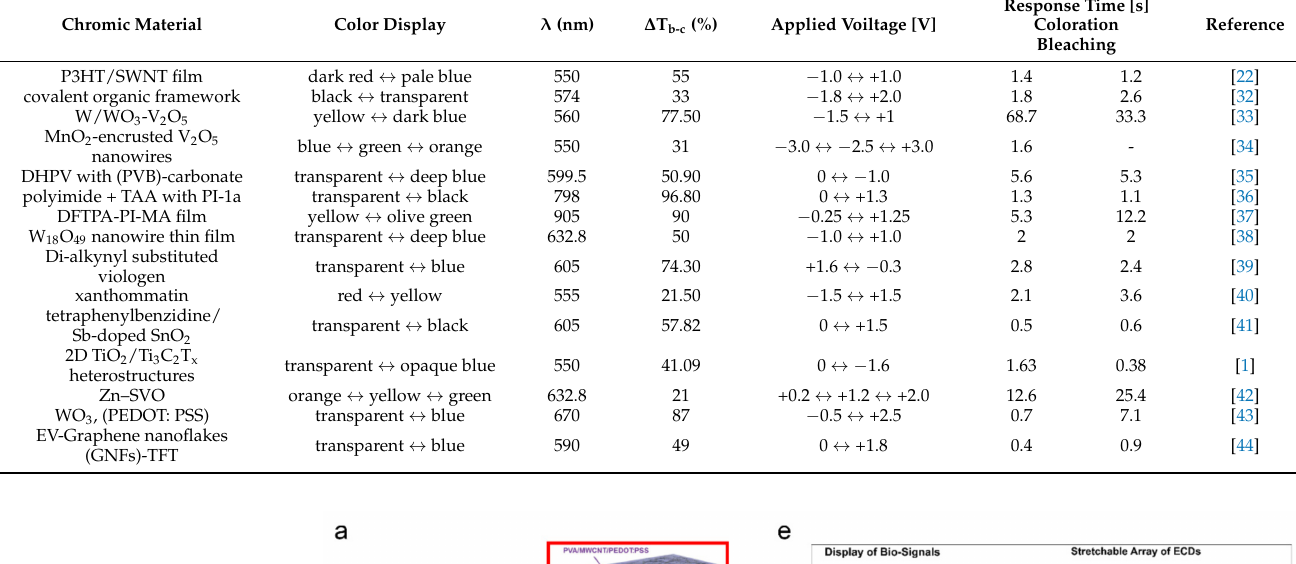
Table 1. Various ECD integrated sensors and devices.